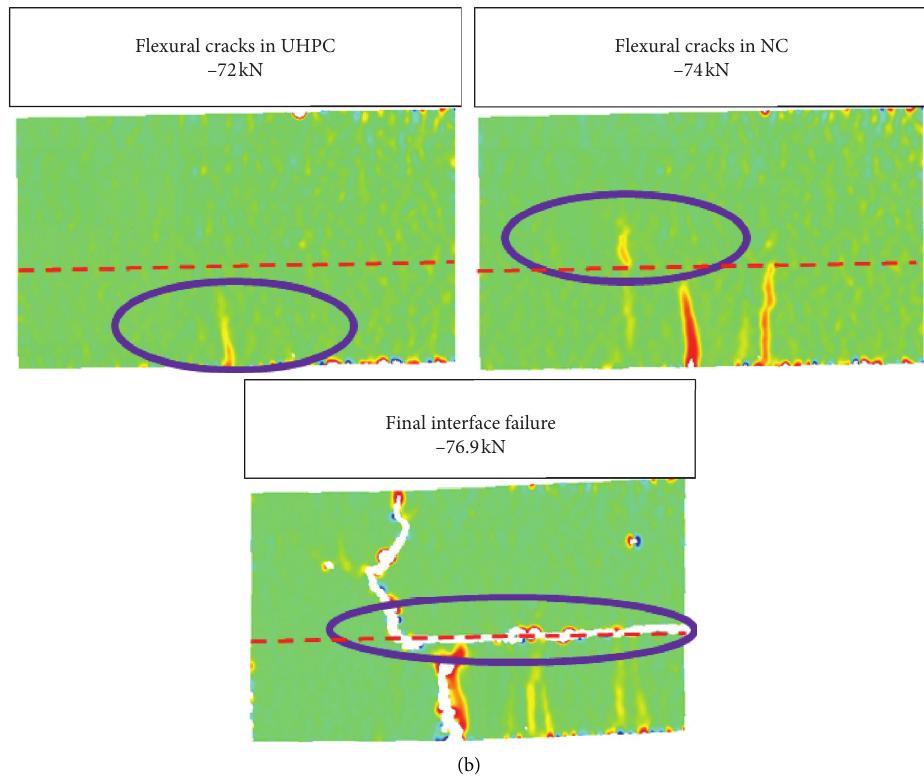
Figure 12: Failure patterns and damage evolutions of specimen U60. (a) Photos for failure pattern. (b) Damage tracking with DIC